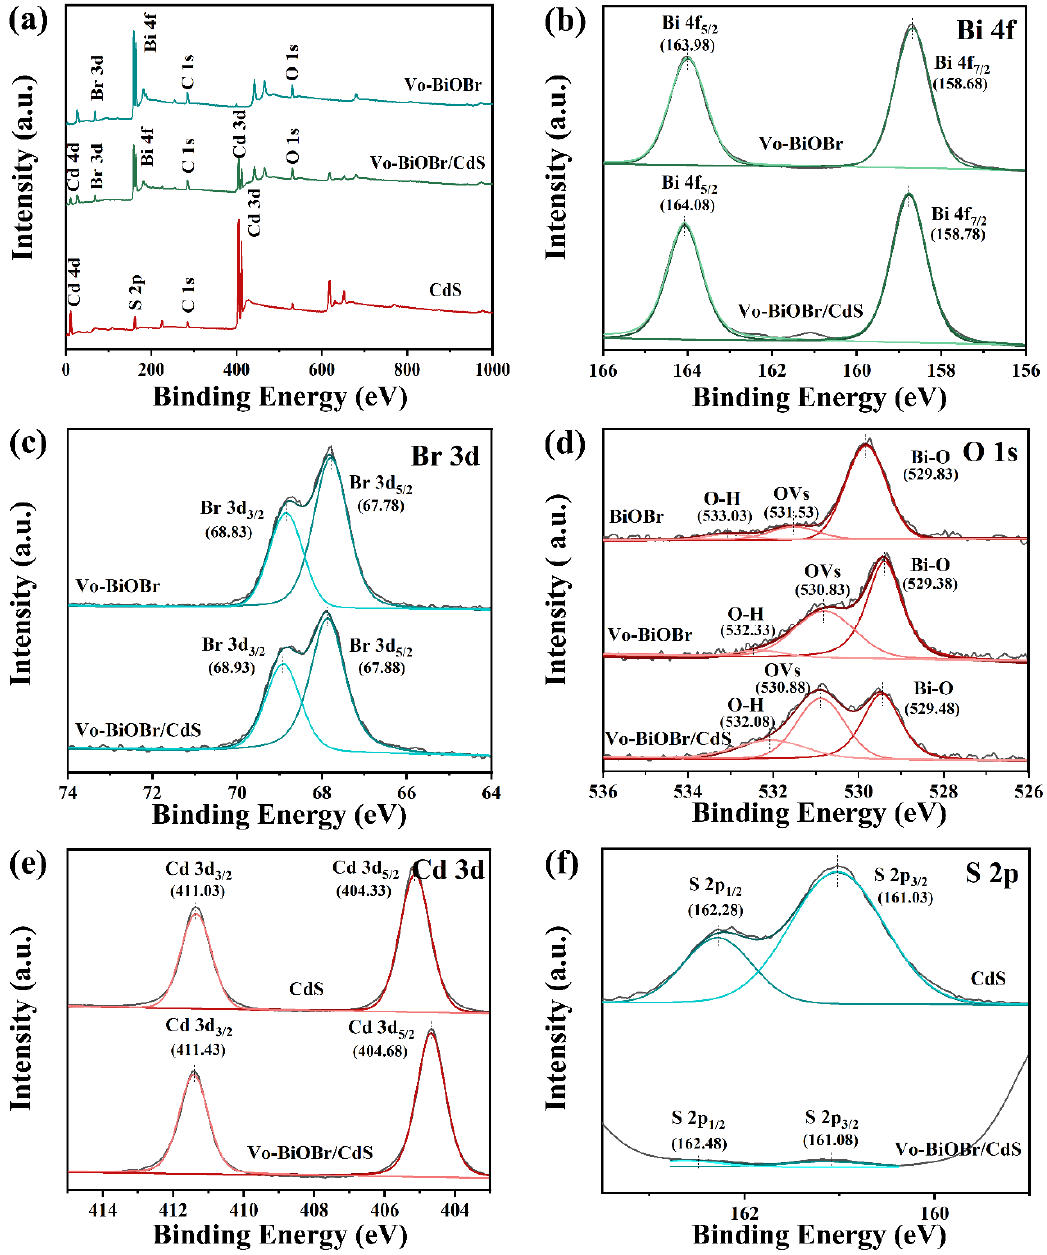
Figure 4. XPS survey spectra of Vo-BiOBr, CdS, and Vo-BiOBr/CdS ( a ); High-resolution XPS spectra of Bi 4f ( b ), Br 3d ( c ), O 1s ( d ), Cd 3d ( e ), and S 2p ( f ) of samples.